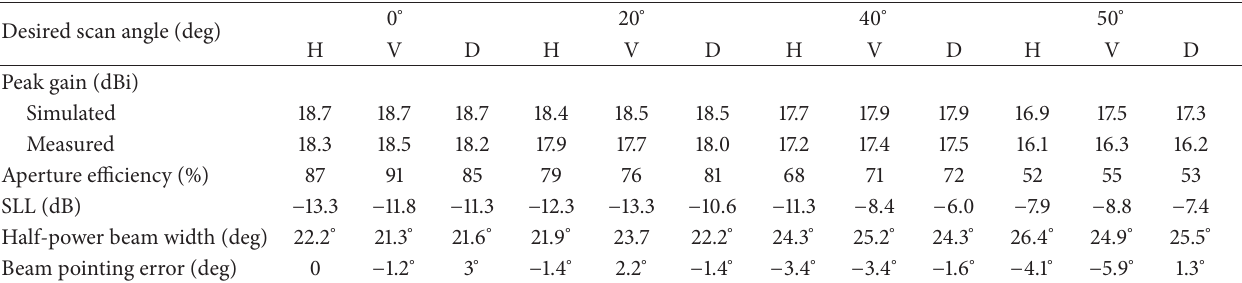
Table 2: The measured data at 12.5 GHz for the developed small phased array